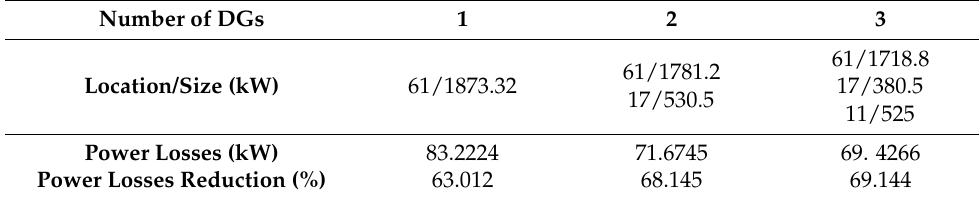
Table 1. Configuration of P-type DGs installed on the IEEE-69